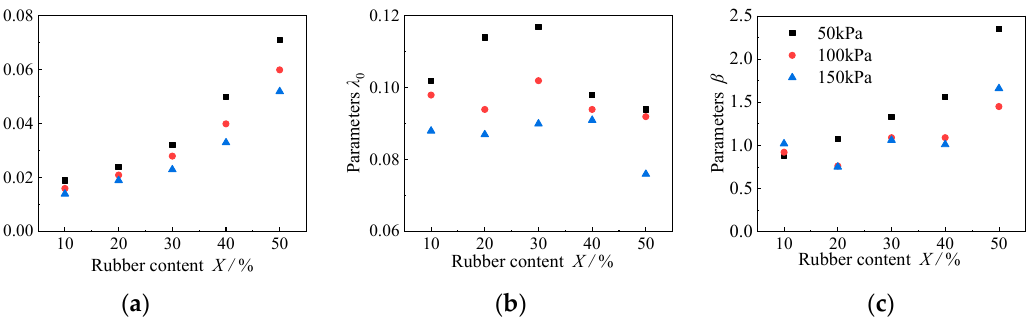
Figure 28. Variations of model parameters with the rubber content and the damping ratio. ( a ) Parameters λ min , ( b ) Parameters λ 0 , ( c ) Parameters β .